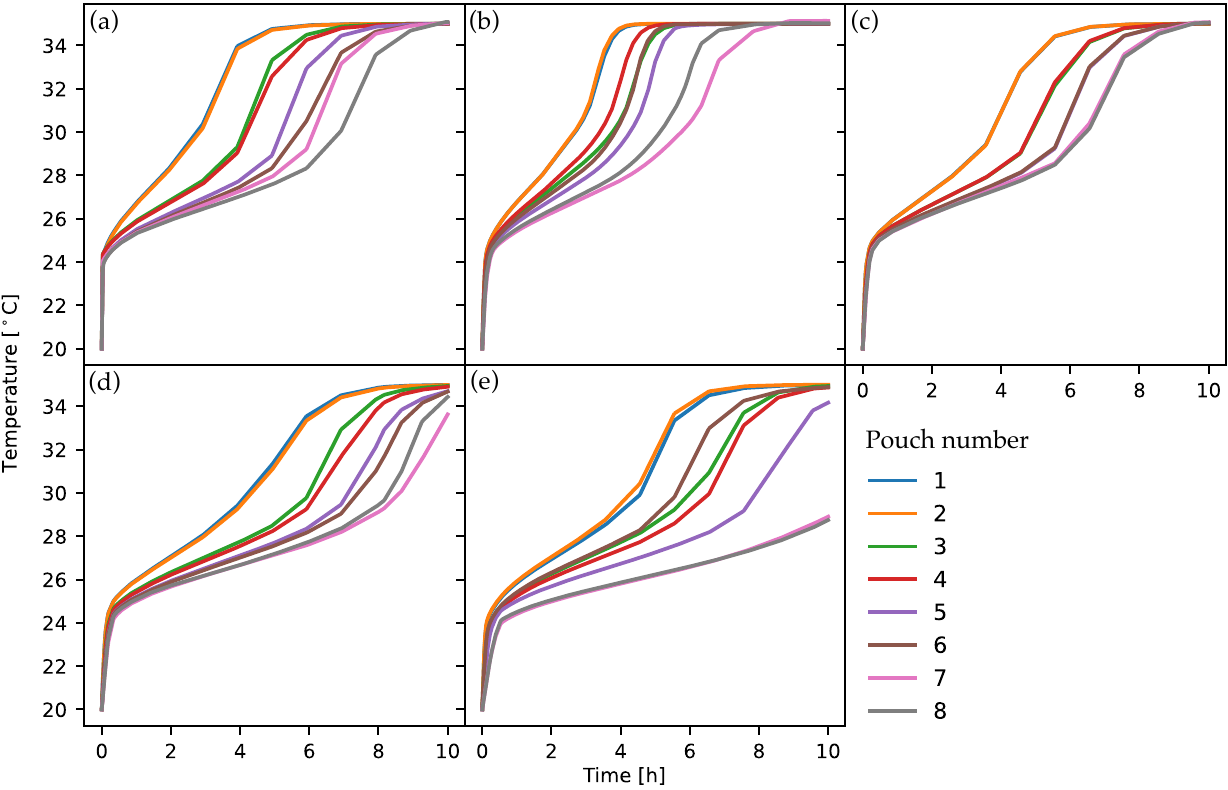
Figure 9. Temperature change with time during charging of the PCM panels for ( a ) PY, ( b ) PYO, ( c ) PYR, ( d ) CY, and ( e ) CYO designs. Arrows indicate completion of phase